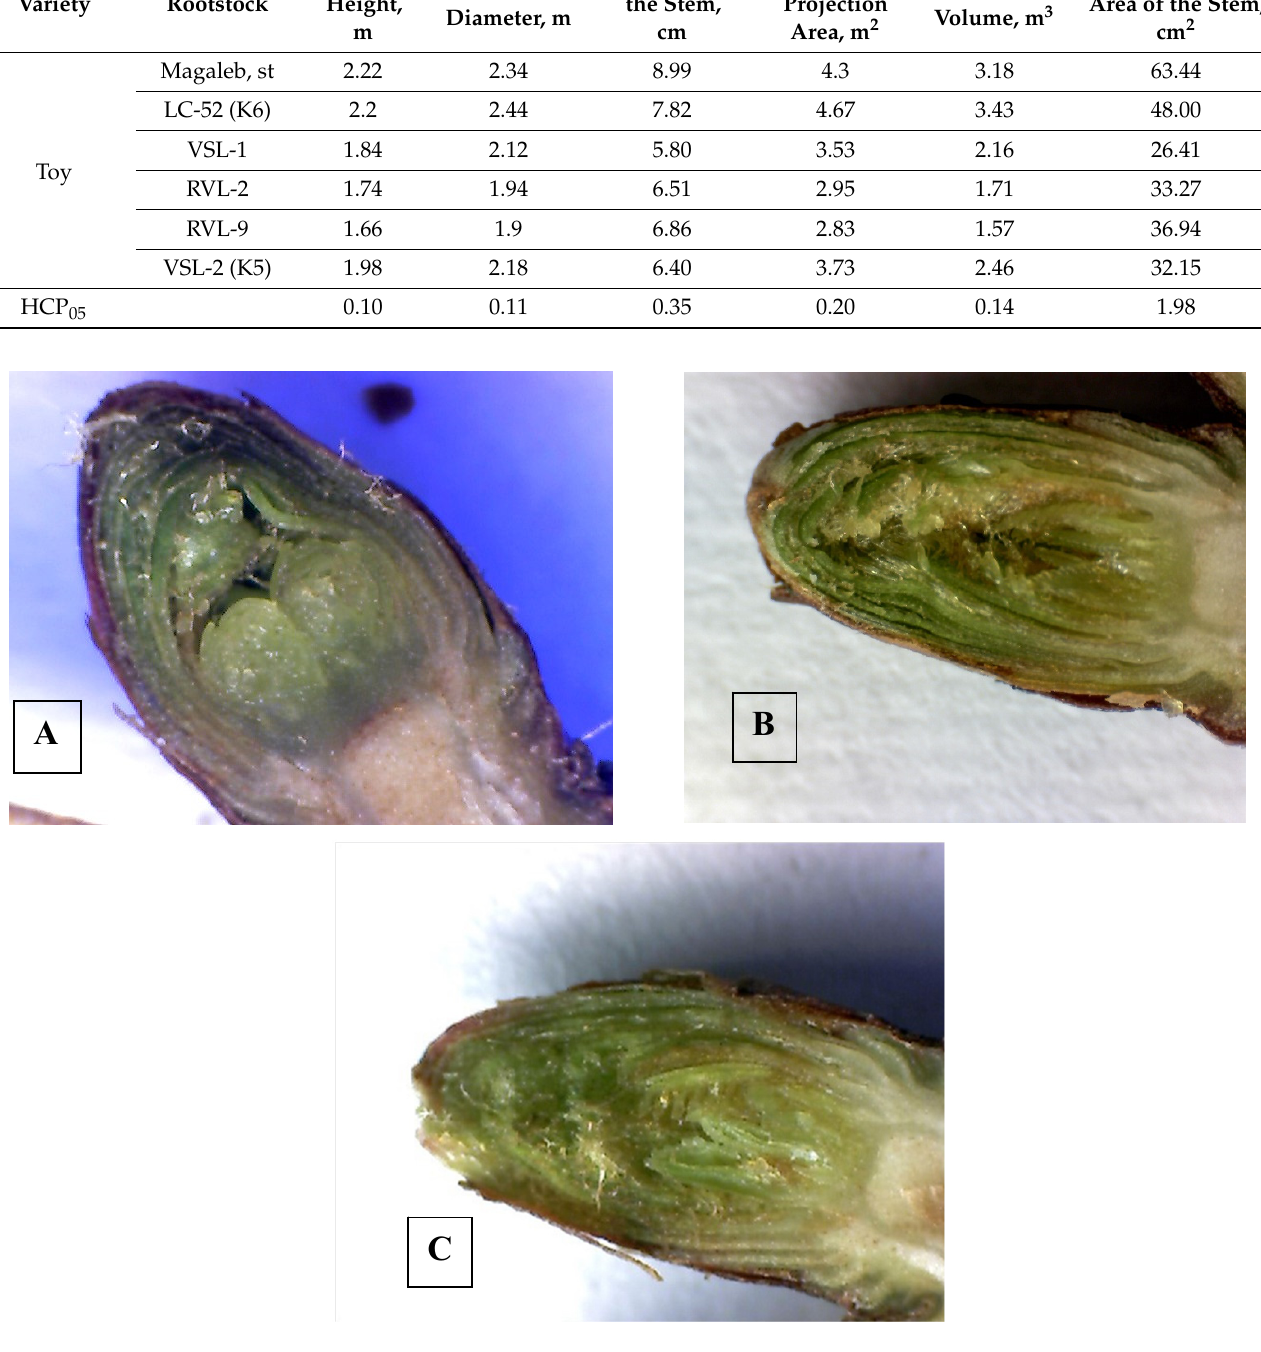
Figure 1. Generative kidneys after freezing in the chamber, varieties: Memory of Zhukova ( A ), Toy ( B ), and Loznovskaya ( C ).